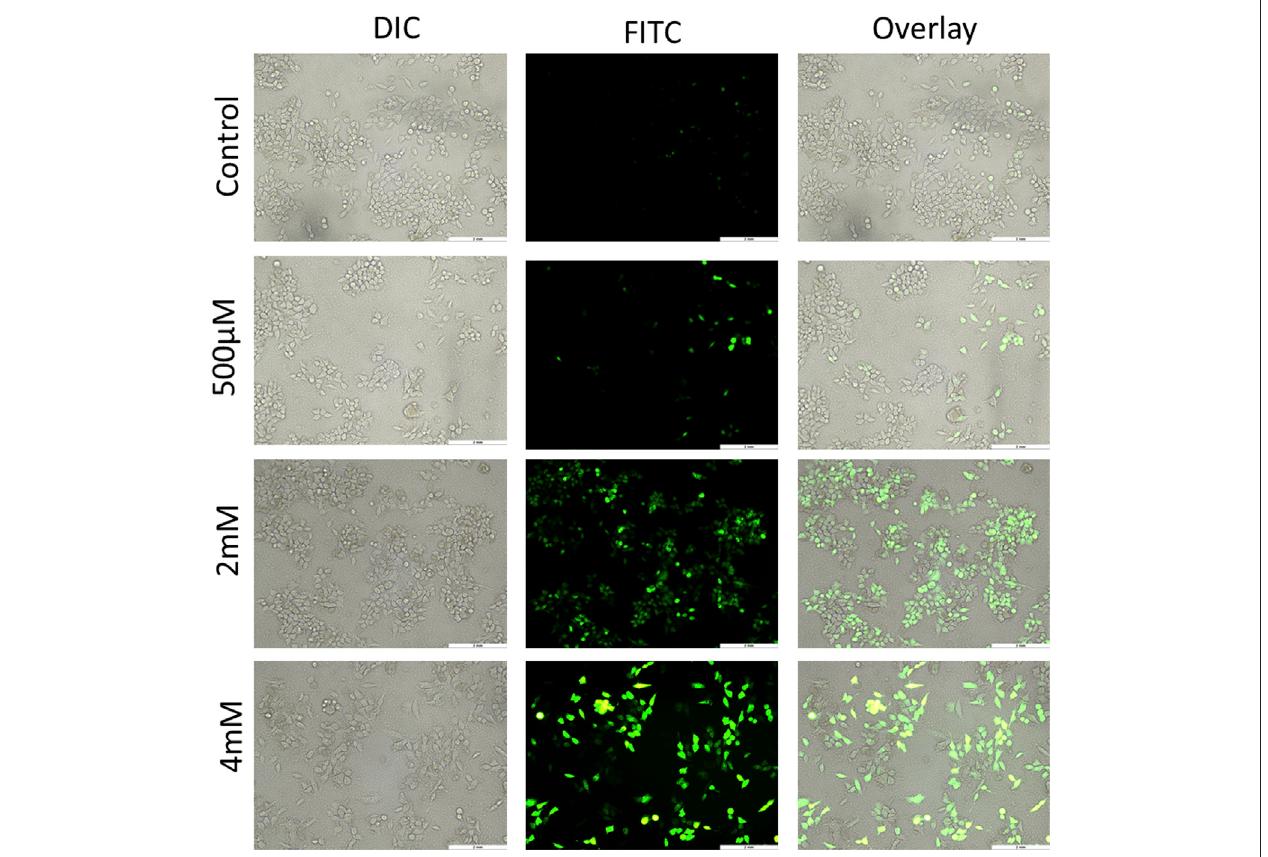
FIGURE 5 | HCT116 cells treated with GIV, analyzed for ROS generation using DCFH-DA dye, and imaged at × 20 magni fi cation. The cells show increased green fl uorescence with increasing concentrations of GIV in comparison with the control cells, indicating ROS generation with GIV treatment.